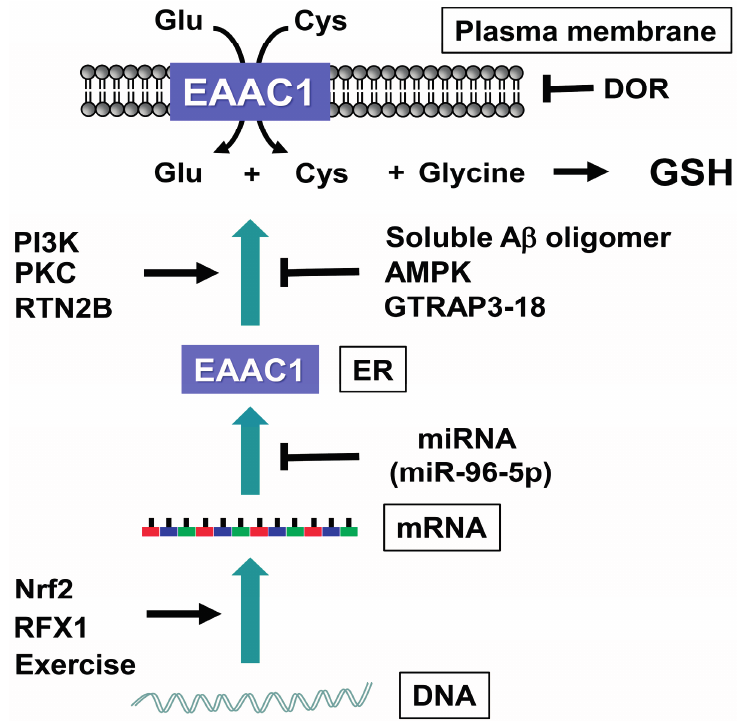
Figure 2. Regulatory mechanisms of EAAC1, which is a neuronal transporter for cysteine (Cys) and glutamate (Glu) uptake for glutathione (GSH) synthesis. Stimulatory ( arrow ) and inhibitory ( ˫ ) regulations for EAAC1 activity. The abbreviations are as follows: AMP-activated protein kinase (AMPK), amyloid β (A β ), endoplasmic reticulum (ER), excitatory amino acid carrier 1 (EAAC1), δ -opioid receptor (DOR), glutamate transport associated protein 3-18 (GTRAP3-18), nuclear factor erythroid 2-related factor 2 (Nrf2), phosphatidylinositol 3-kinase (PI3K), protein kinase C (PKC), regulatory factor X1